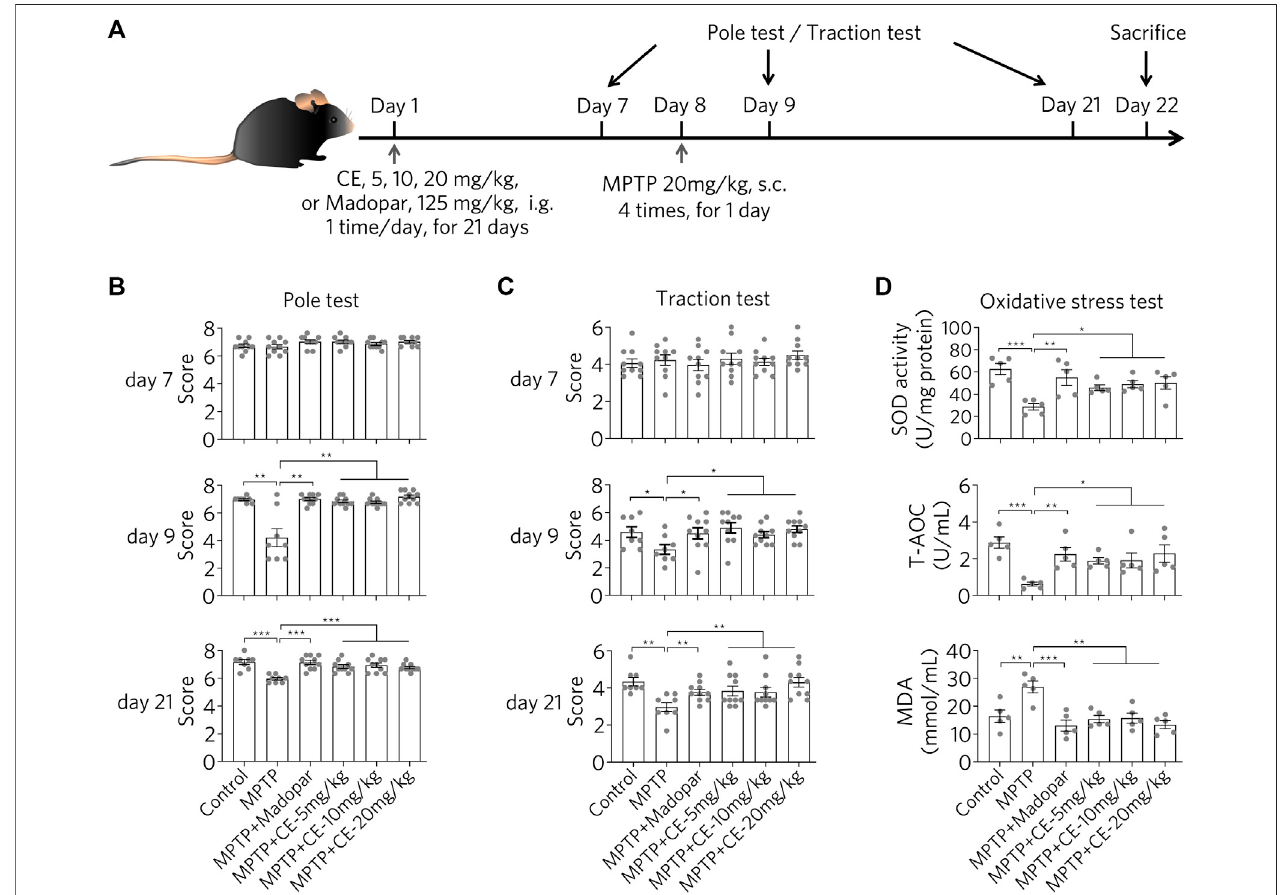
FIGURE 1 | CE attenuates MPTP-induced neurotoxicity in mice. (A) Experimental fl ow of the MPTP-induced PD mouse model. (B,C) Behavioral analyses were performed at days 7, 9 and 21, including the pole test and traction test. Non-parametric analyses were determined by Mann-Whitney test, n = 10. (D) CE attenuates oxidative stress and promotes MDA clearance in substantia nigra. One-way ANOVA with post hoc Dunnett ’ s test, n = 5.